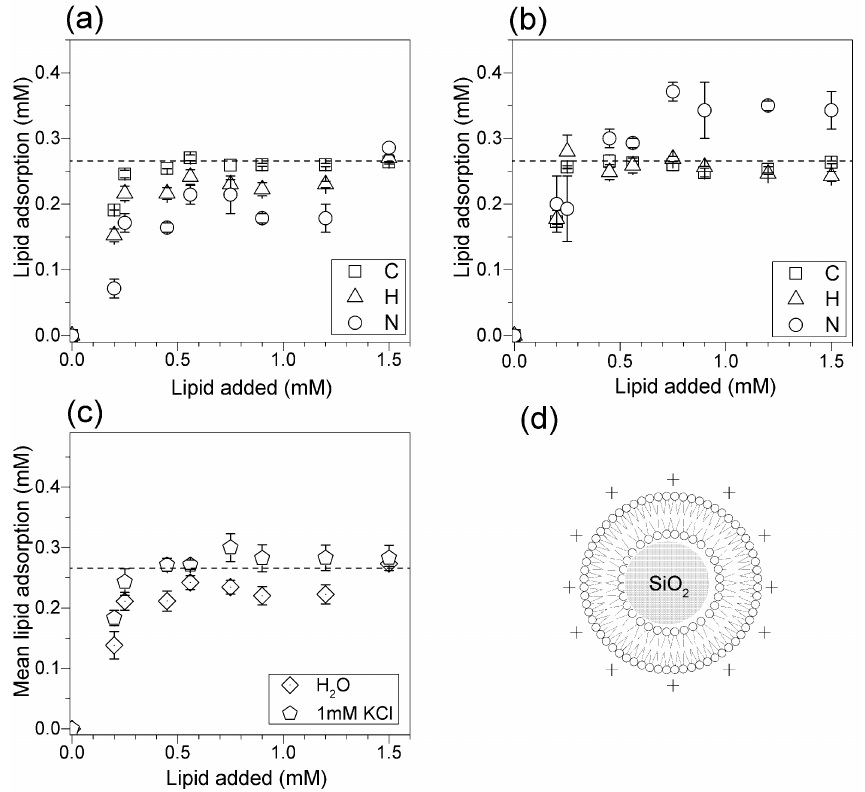
Figure 5. Adsorption isotherms for DOTAP onto silica. ( a ) Adsorption isotherms for DOTAP onto silica from DOTAP films in pure water. ( b ) Adsorption isotherms for DOTAP onto silica from DOTAP films in 1 mM KCl. ( c ) Mean DOTAP adsorption onto silica from DOTAP films in water or in KCl 1 mM aqueous solution. ( d ) Cross-section of a silica NP covered by a DOTAP cationic bilayer. The dashed line at 0.266 mM DOTAP represents the theoretical concentration for bilayer adsorption. Silica concentration was 2 mg/mL. Each mean adsorption value and the respective mean standard deviation was obtained from at least two different determinations for each element.